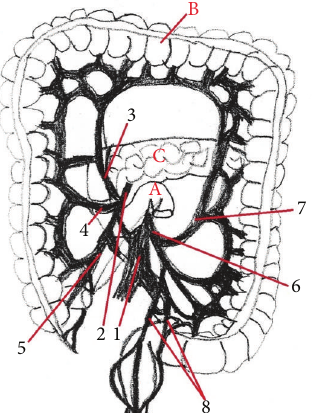
Figure 13: The division of the a. mesenterica superior in human. 1: aorta abdominalis , 2: a. mesenterica inferior , 3: a. colica media , 4: a. colica dextra , 5: a. ileocolica , 6: a. mesenterica inferior , 7: a. colica sin- istra , 8: aa. rectales superiores , A: flexura duodenojejunalis , B: colon , and C: pancreas